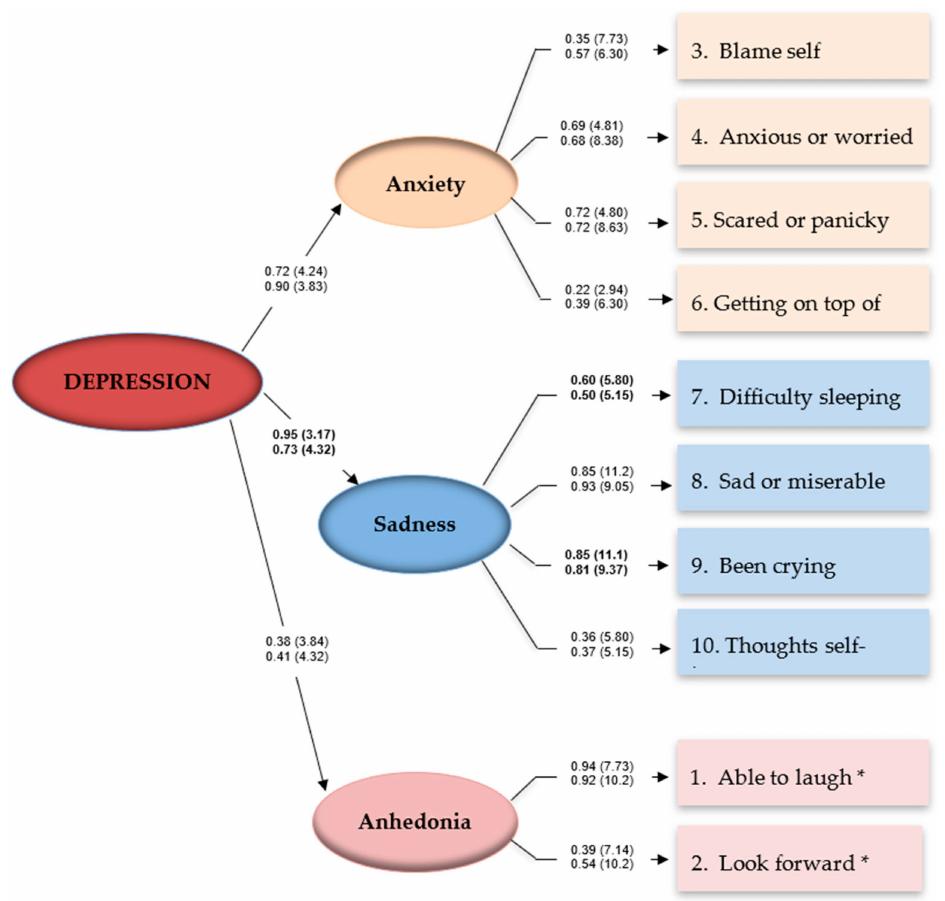
Figure 1. Three-factor model of depressive symptoms, pregnancy and postpartum, Bedouin mothers in Southern Israel. Note: Coefficients for the pregnancy model are above coefficients for the post-birth model. Parameters are expressed as maximum likelihood estimates (standardized solutions). Paren- thetical numbers indicate significance levels (CR > 1.96, p < 0.05; CR > 2.58, p < 0.01). * Anhedonia items are